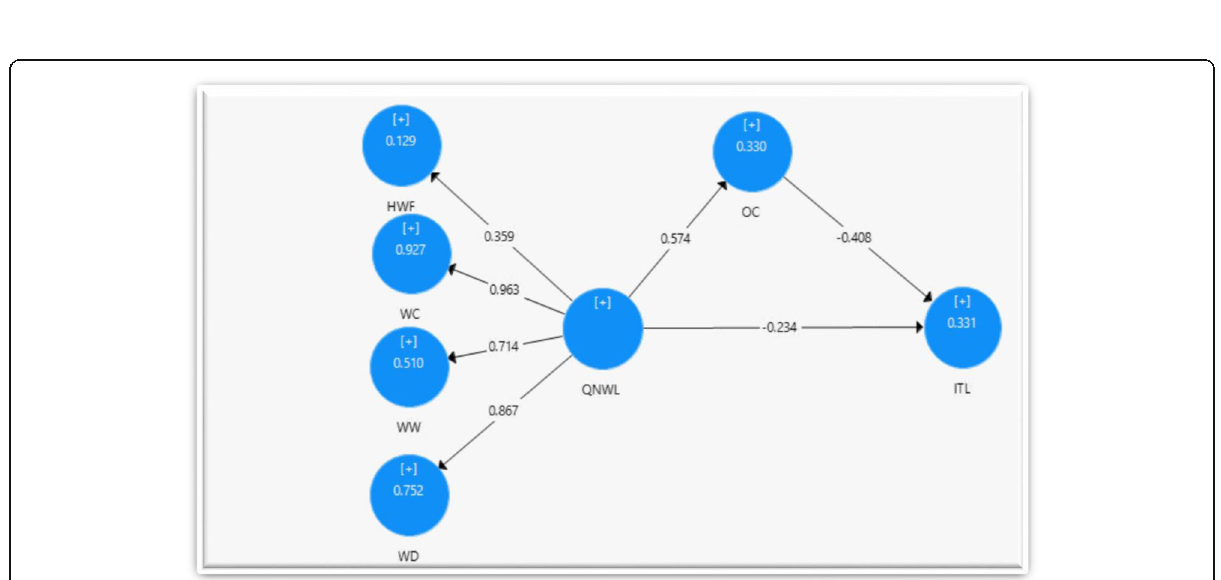
Fig. 3 Structural model with mediator